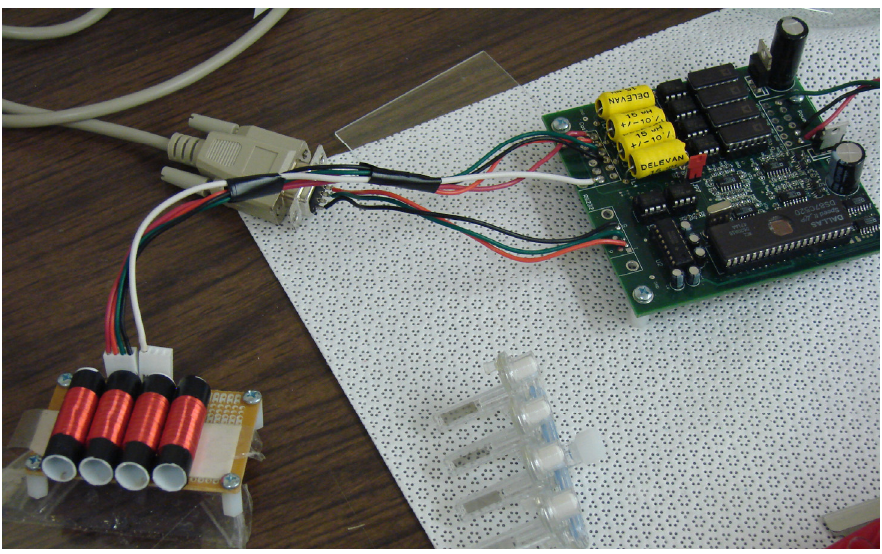
Figure 11. Picture of the four-channel micro-controller based magnetoelastic circuit board, with four solenoid coils shown in foreground. Reprinted with permission from